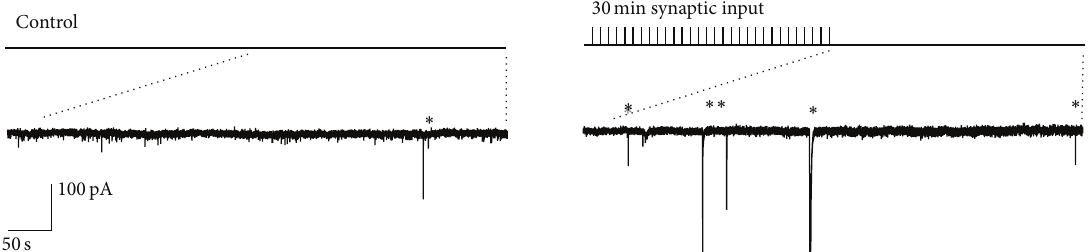
Figure 5: Long term enhancement (LTE) of astrocyte-derived slow inward currents (SICs). This representative example shows an increase in SICs recorded from thalamocortical neurons 60 minutes after 30 minutes of repetitive burst stimulation (10–20 stimulations at 50 Hz, every 5–10 seconds) of lemniscal and cortical afferents. Asterisks represent